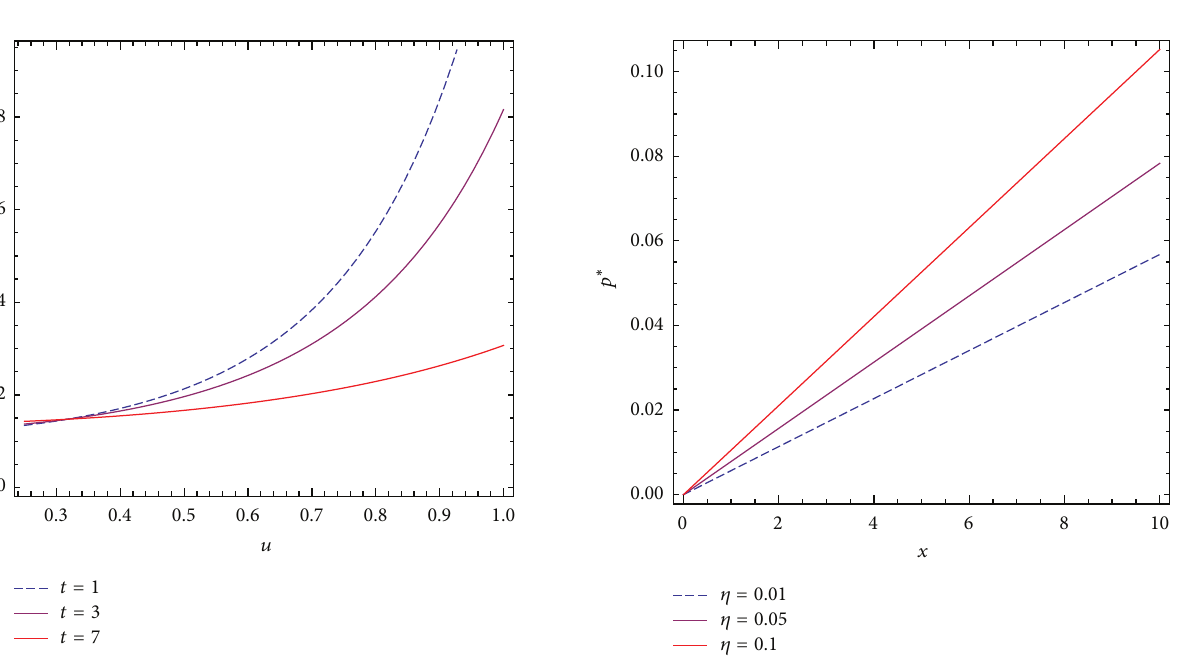
Figure 5: The optimal reinsurance proportion varies with respect to 𝑥 at different 𝜂 .